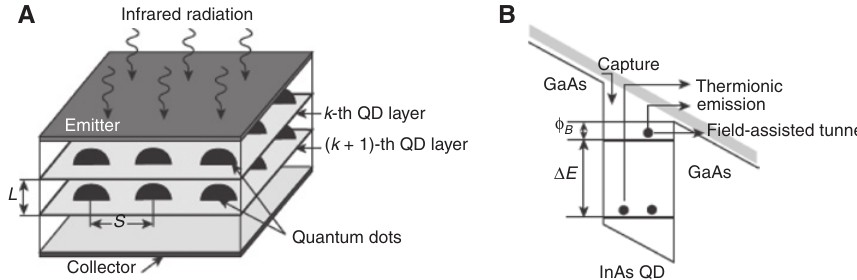
Figure 5: Schematic view of (A) the quantum dot structure and (B) the conduction band of the QD